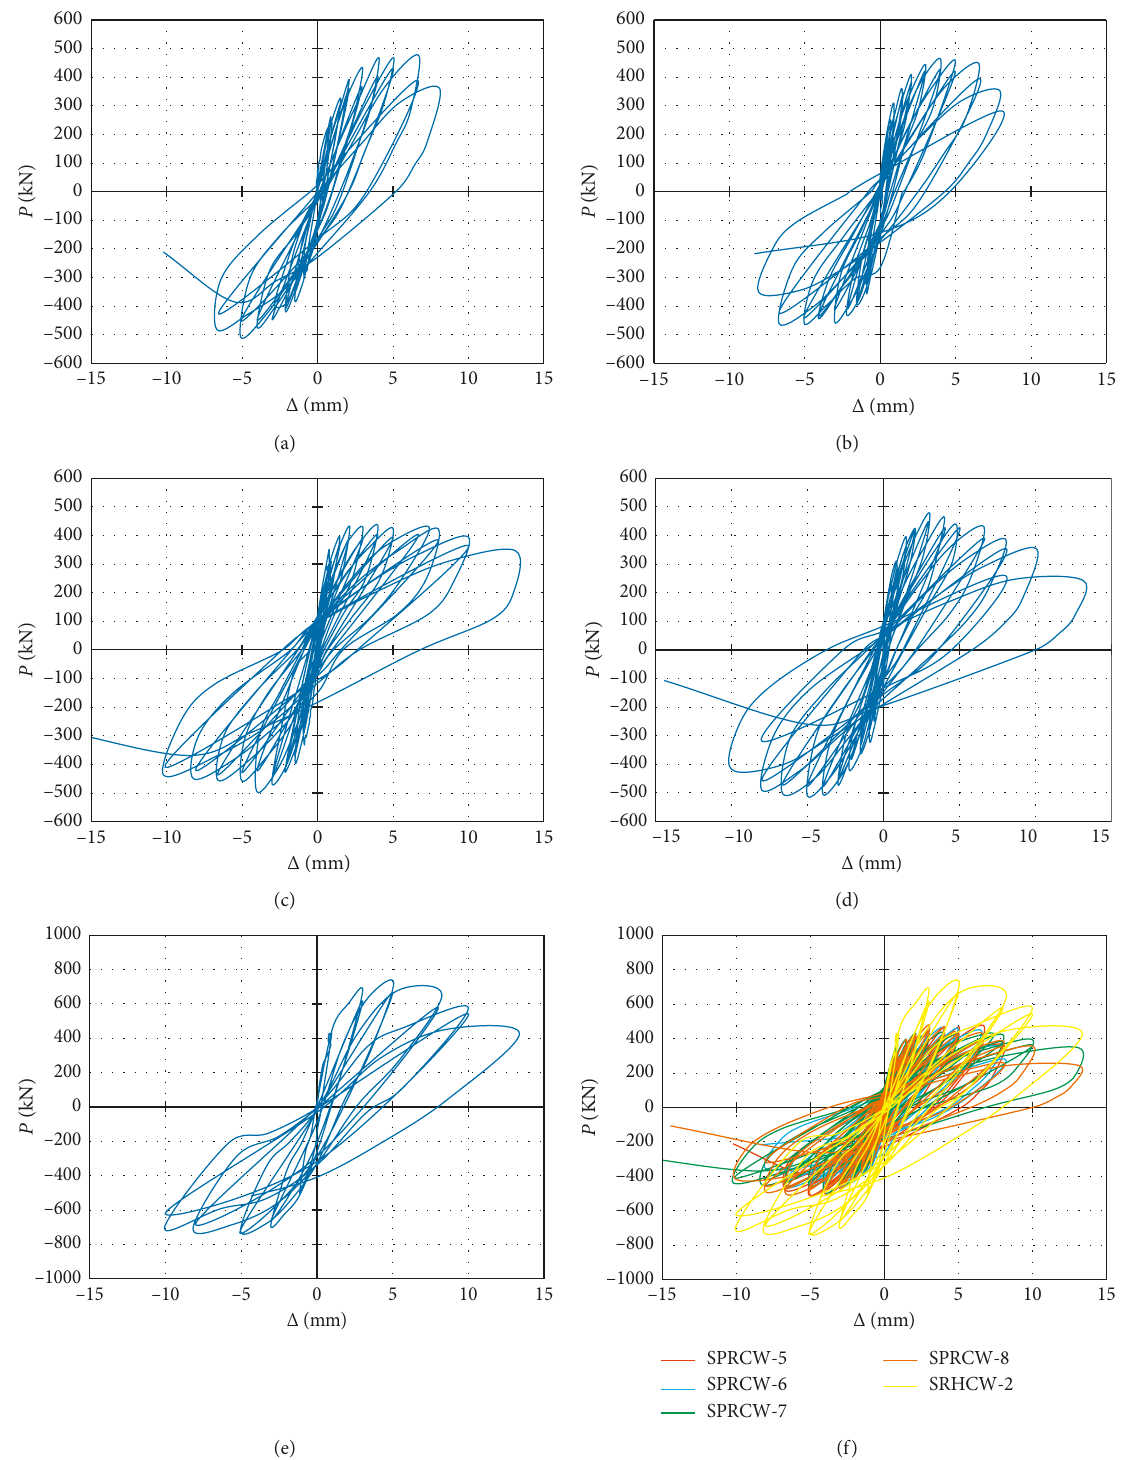
Figure 11: Hysteretic curves of shear wall test pieces. (a) SPRCW-5 P- Δ hysteretic curve. (b) SPRCW-6 P- Δ hysteretic curve. (c) SPRCW-7 P- Δ hysteretic curve. (d) SPRCW-8 P- Δ hysteretic curve. (e) SRHCW-2 P- Δ hysteretic curve. (f) Hysteretic curves of all test